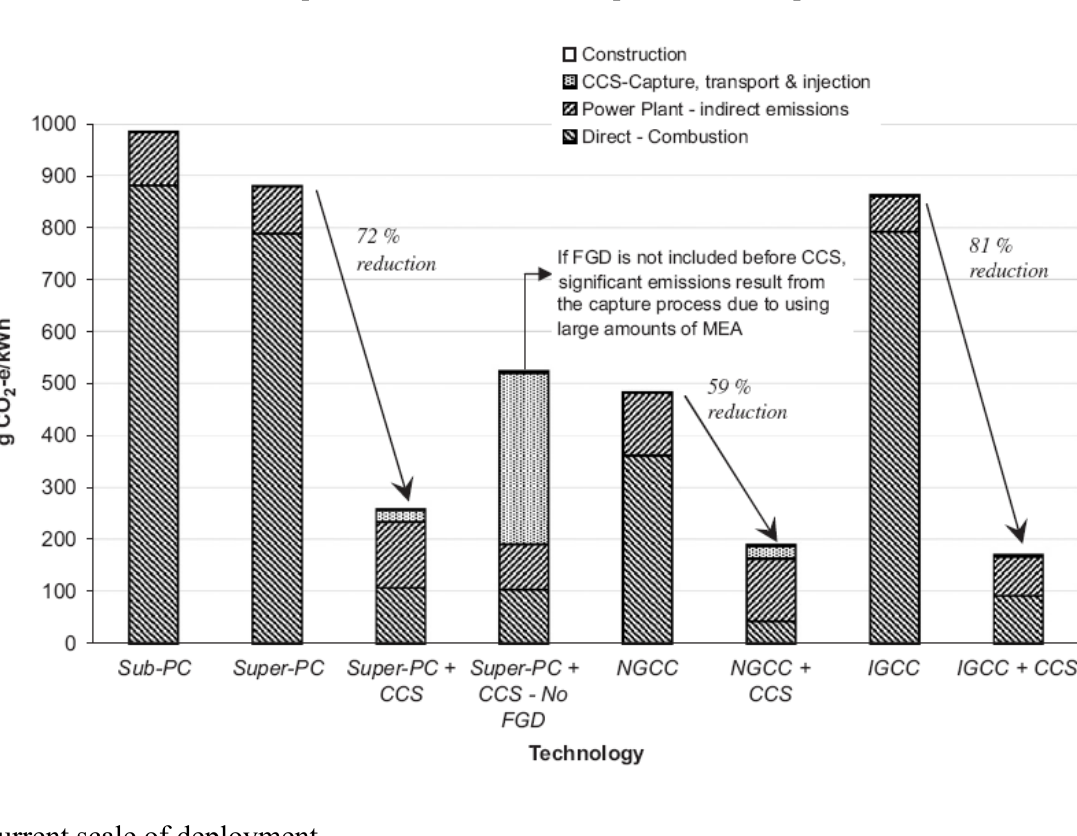
Figure 11. Comparison of greenhouse gas emissions from power plants equipped with carbon capture systems (PC – Pulverised coal, FGD – Flue gas desulphurisation, NGCC – Natural gas combined cycle, IGCC–Integrated gasifier combined cycle). Carbon capture for PC and NGCC via post-combustion using MEA as solvent, for IGCC pre-combustion (Selexol process). Note that in the absence of FGD, life-cycle emissions reacts with the MEA solvent, rendering it unusable for increase dramatically, because SO 2 further downstream CO capture. © 2008 Elsevier, reproduced with permission from 2